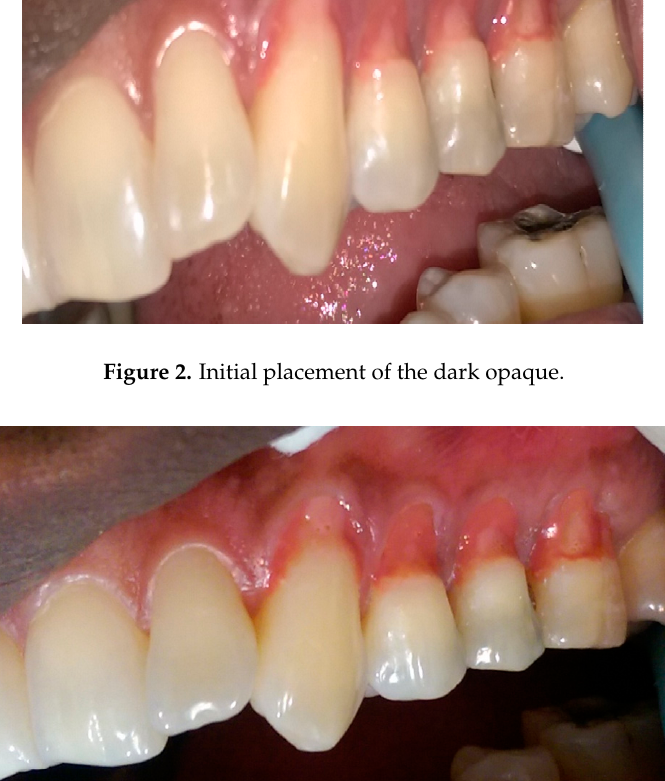
Figure 4. Blending of dark, white and light opaquers.